Question: Condense the content of this figure into a single sentence.
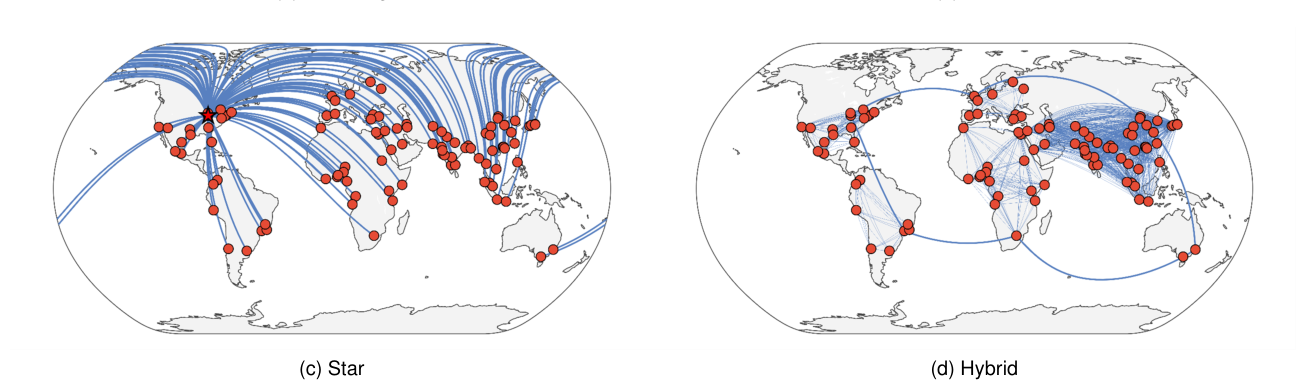
Answer: Illustrations of imagined DFL network topologies in the real world: (a) line/ring, (b) mesh, (c) star, and (d) hybrid. The red dots represent clients, which can be universities, institutions, or organizations in some of the major cities in the world (determined by population). The blue lines depict the communication network among these clients. Depending on the chosen topology, the communication networks exhibit different communication distances, number of communication links, complexity, and other characteristics.